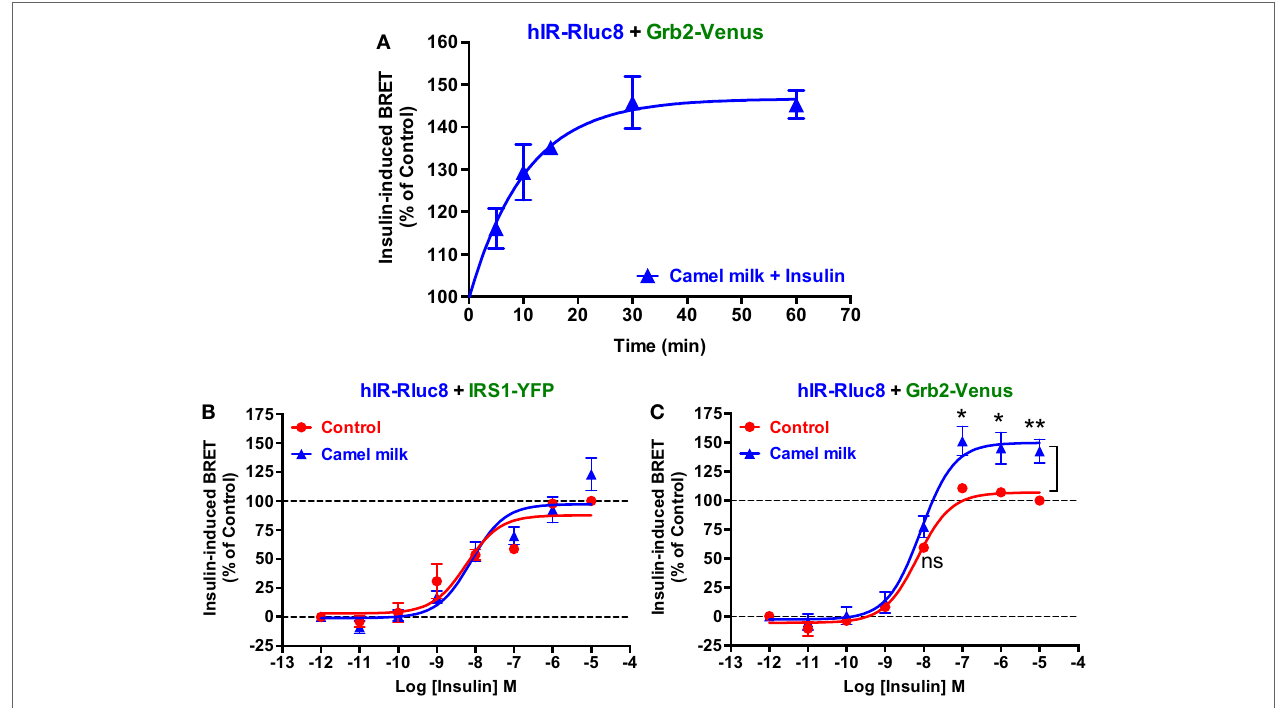
FigUre 3 | Time-course and dose–response analysis of the effect of camel milk on BreT signals. HEK293 cells transiently co-expressing hIR–Rluc8 and either Grb2–Venus (a,c) or IRS1–YFP (B) were first pre-treated (blue triangle) or not (red circle) different times (a) or 30 min (B,c) with camel milk before BRET measurements were performed in the absence or presence of stimulation with 100 nM (a) or increasing doses (B,c) of insulin as indicated. Data are mean ± SEM of three (a,B) or six (c) independent experiments performed in triplicate